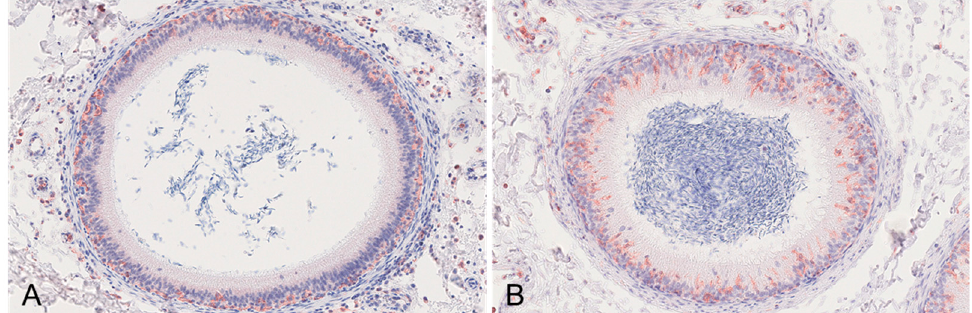
tained few ASFV antigen-positive cells (arrow). Inset: A single myofibroblast within the smooth Figure 4. Iba-1 immunohistochemistry of epididymal tubules. ( A ) IHC, anti-p72, boar #1; Iba-1-pos- muscle layer was positive for the p72 antigen. itive macrophages were located in the basal epithelium, in the smooth muscle layer and stroma